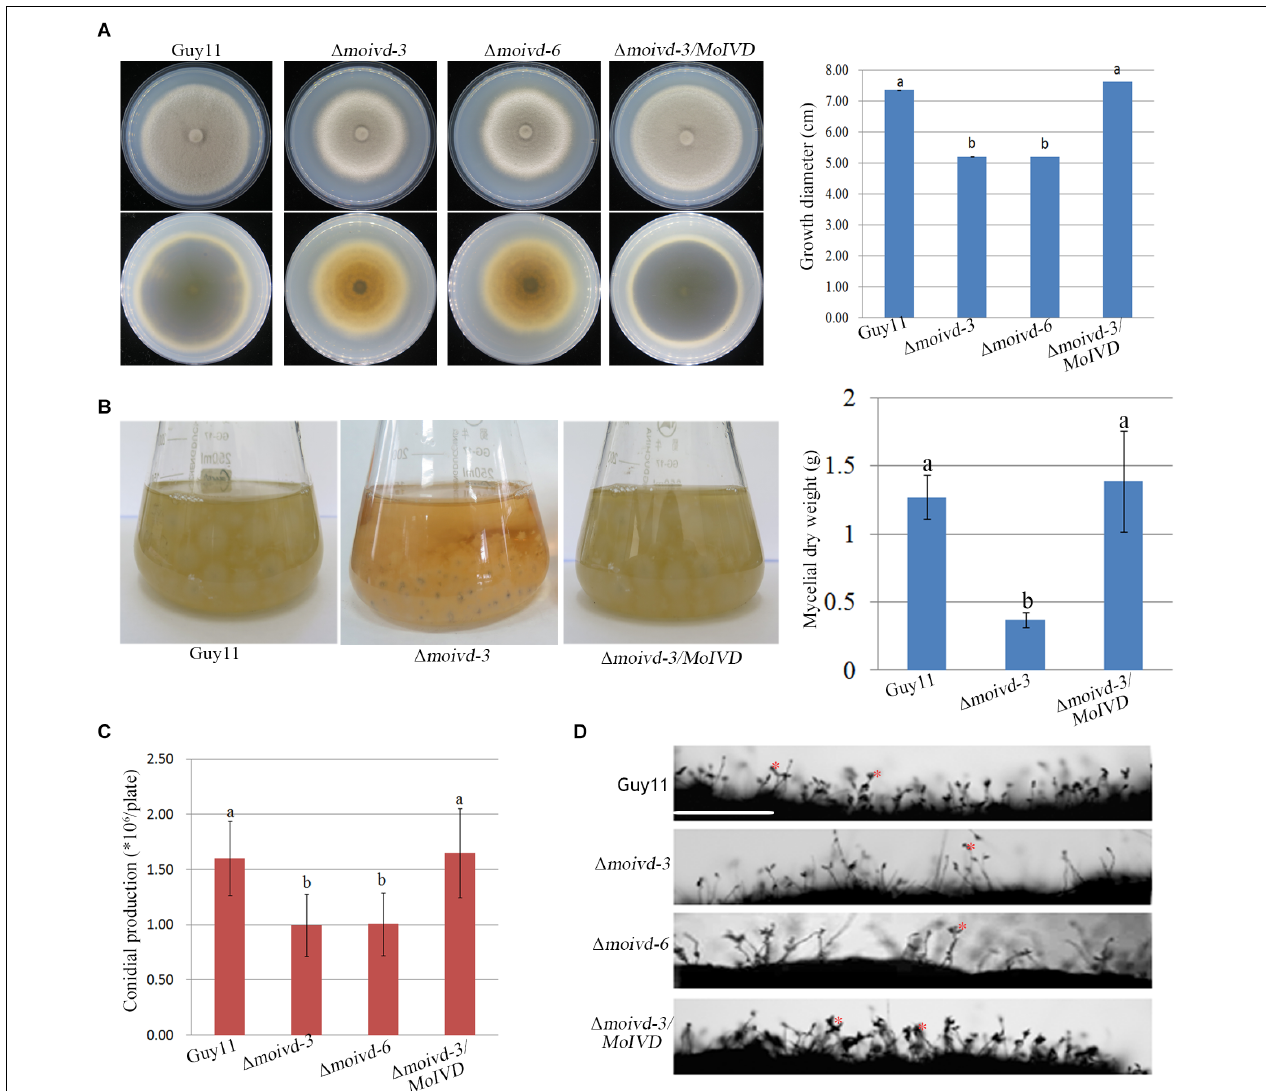
FIGURE 3 | The growth and conidiation phenotype of the (cid:49) moivd mutants. (A) The colonial morphology of the (cid:49) moivd mutants growing on complete medium for 10 days. The upper left panel is the colony outlook. The lower left panel is the opposite side of culture plate. The bar chart in the right shows the growth size of the (cid:49) moivd mutants. (B) The culture morphogenesis of (cid:49) moivd-3 incubated in liquid CM for 48h in flask (left) and bar chart showing the dry weight of (cid:49) moivd-3 culture (right). (C) Bar chart showing the conidial production of the (cid:49) moivd mutants by culture on complete medium for 12 days. (D) Microscopic observation of the sporulating structures of the (cid:49) moivd mutants. ∗ indicates conidia developed from conidiophores. Bar = 50 µ m. All the data in this figure were calculated from three independent replicates. Lowercase ‘a’ or ‘b’ on the sample bar indicate no significant differences between samples. The different lowercase letters indicate significant differences ( P < 0.05; t